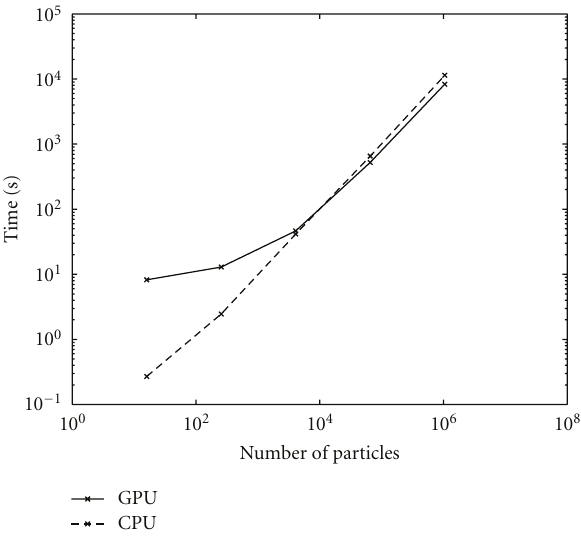
Figure 8: Comparison of time used for GPU and